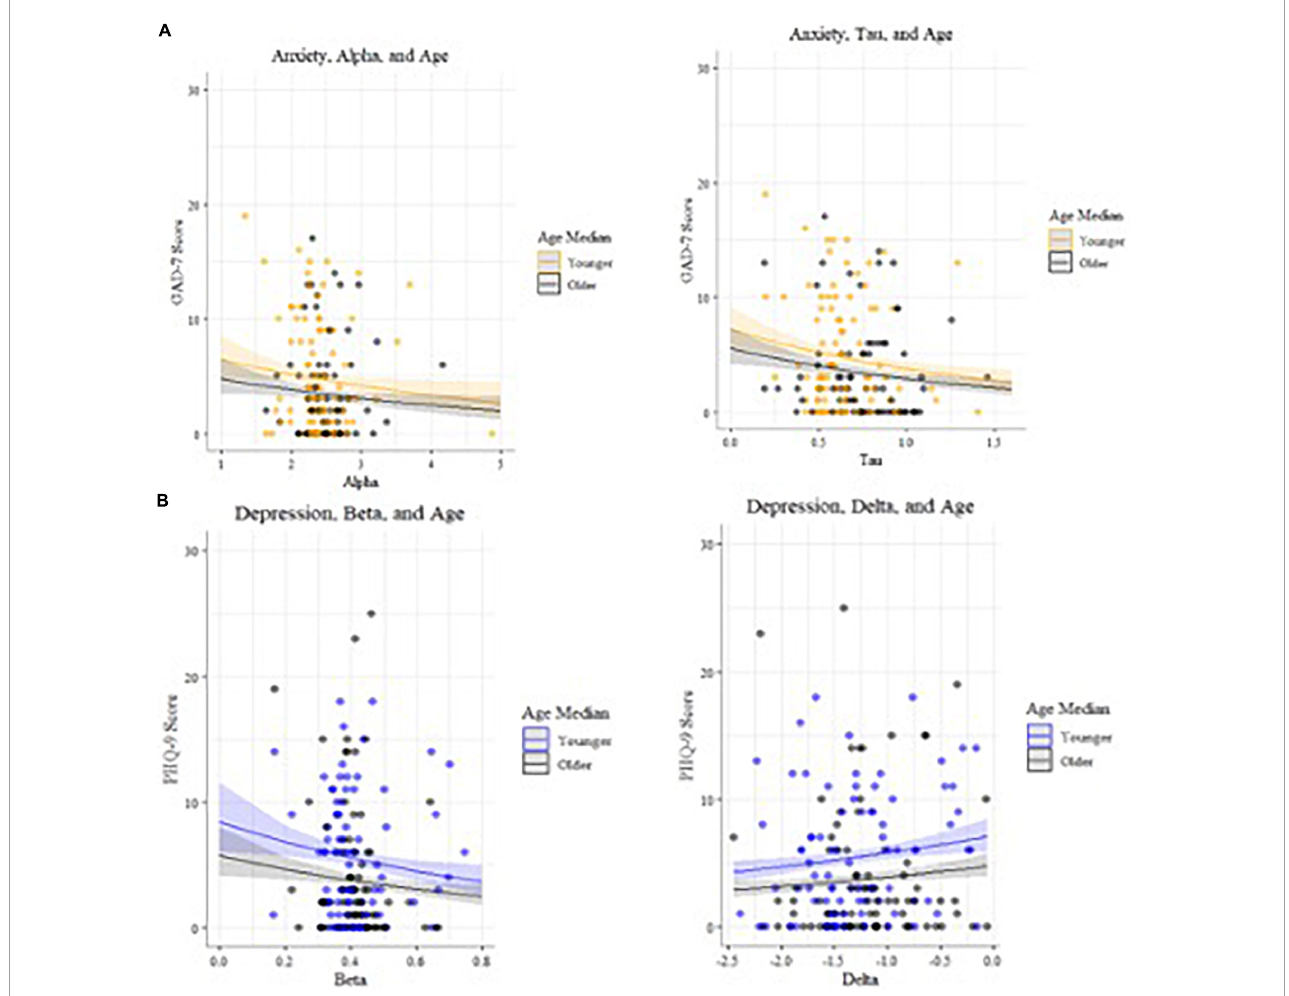
FIGURE7 (A) Models of anxiety predictors, plotted by age (median split used for visualization purposes). (B) Models of depression predictors, plotted by age (median split used for visualization purposes).